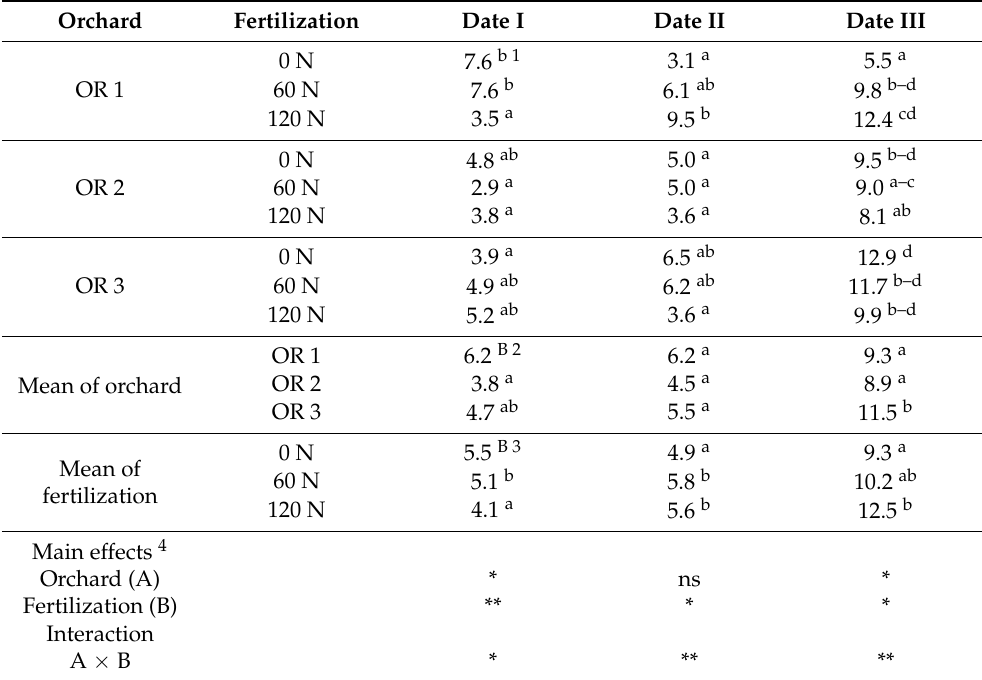
Table 4. Influence of nitrogen fertilization on protease activity in 2008–2010 (mg tyrosine 24 h − 1 kg − 1 DW soil).